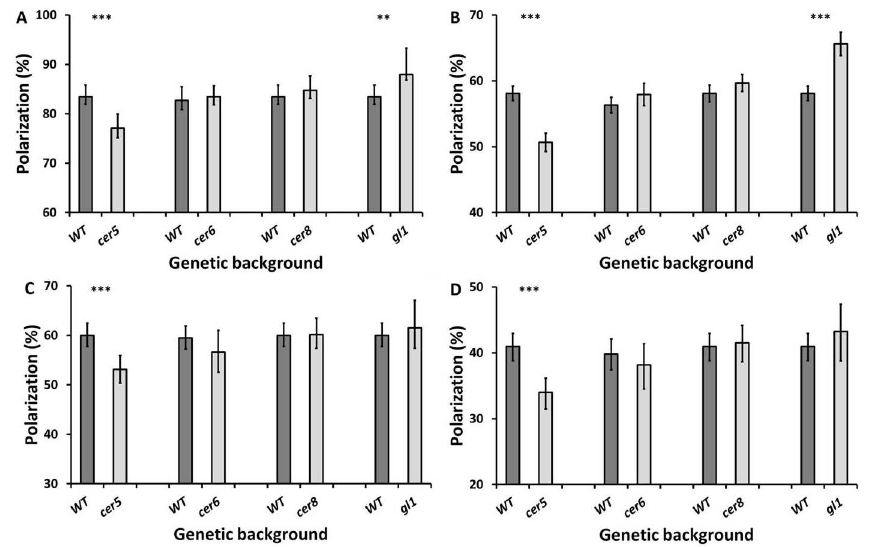
Fig 1. Average percentage polarization of light reflected from the adaxial (A,B) and abaxial (C,D) surfacesof cer5 , cer6 , cer8 and gl1 leaves, in comparison to the L er WT, in the blue (A,C) and green (B,D) channels. Error bars denote 95% confidenceintervals of the means; asterisks indicatestatistically significantdifferences betweenhealthyand infected leaves ( ** P < 0.01, *** P < 0.001).